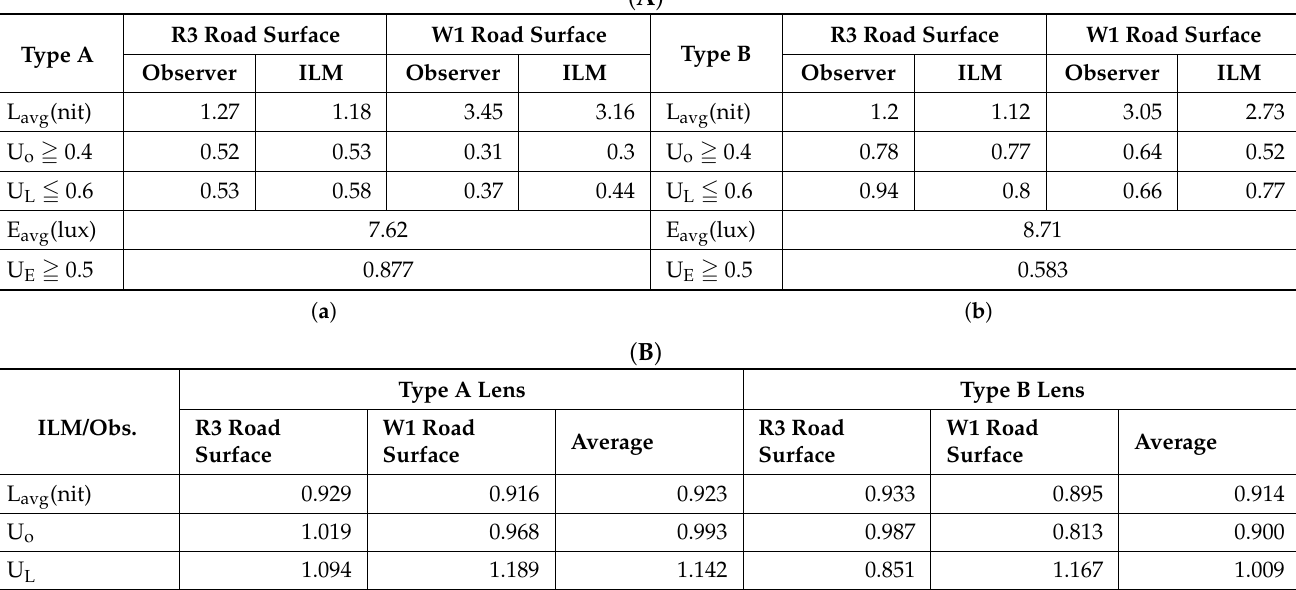
Figure 21. ( A ) Luminance contour map of the Type A lens on the R3 road surface: ( a ) ILM; ( b ) observer. ( B ) Luminance contour map of the Type B lens on the W1 road surface: ( c ) ILM; ( d ) observer. Table 6. ( A ) The relationship of DIALux simulation between the ILM and the observer on the R3 and W1 road surfaces: ( a ) Type A lens; ( b ) Type B lens. ( B ) The ratio of ILM and observer about Type A and Type B lenses. ( A )